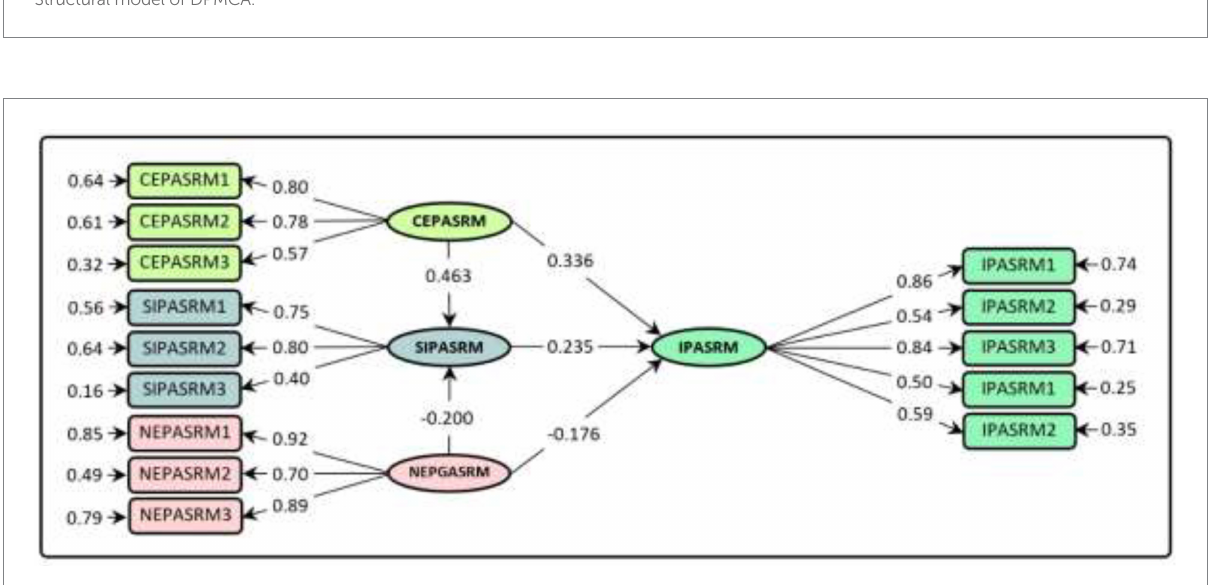
FIGURE 3 Structural model of DPMCA.